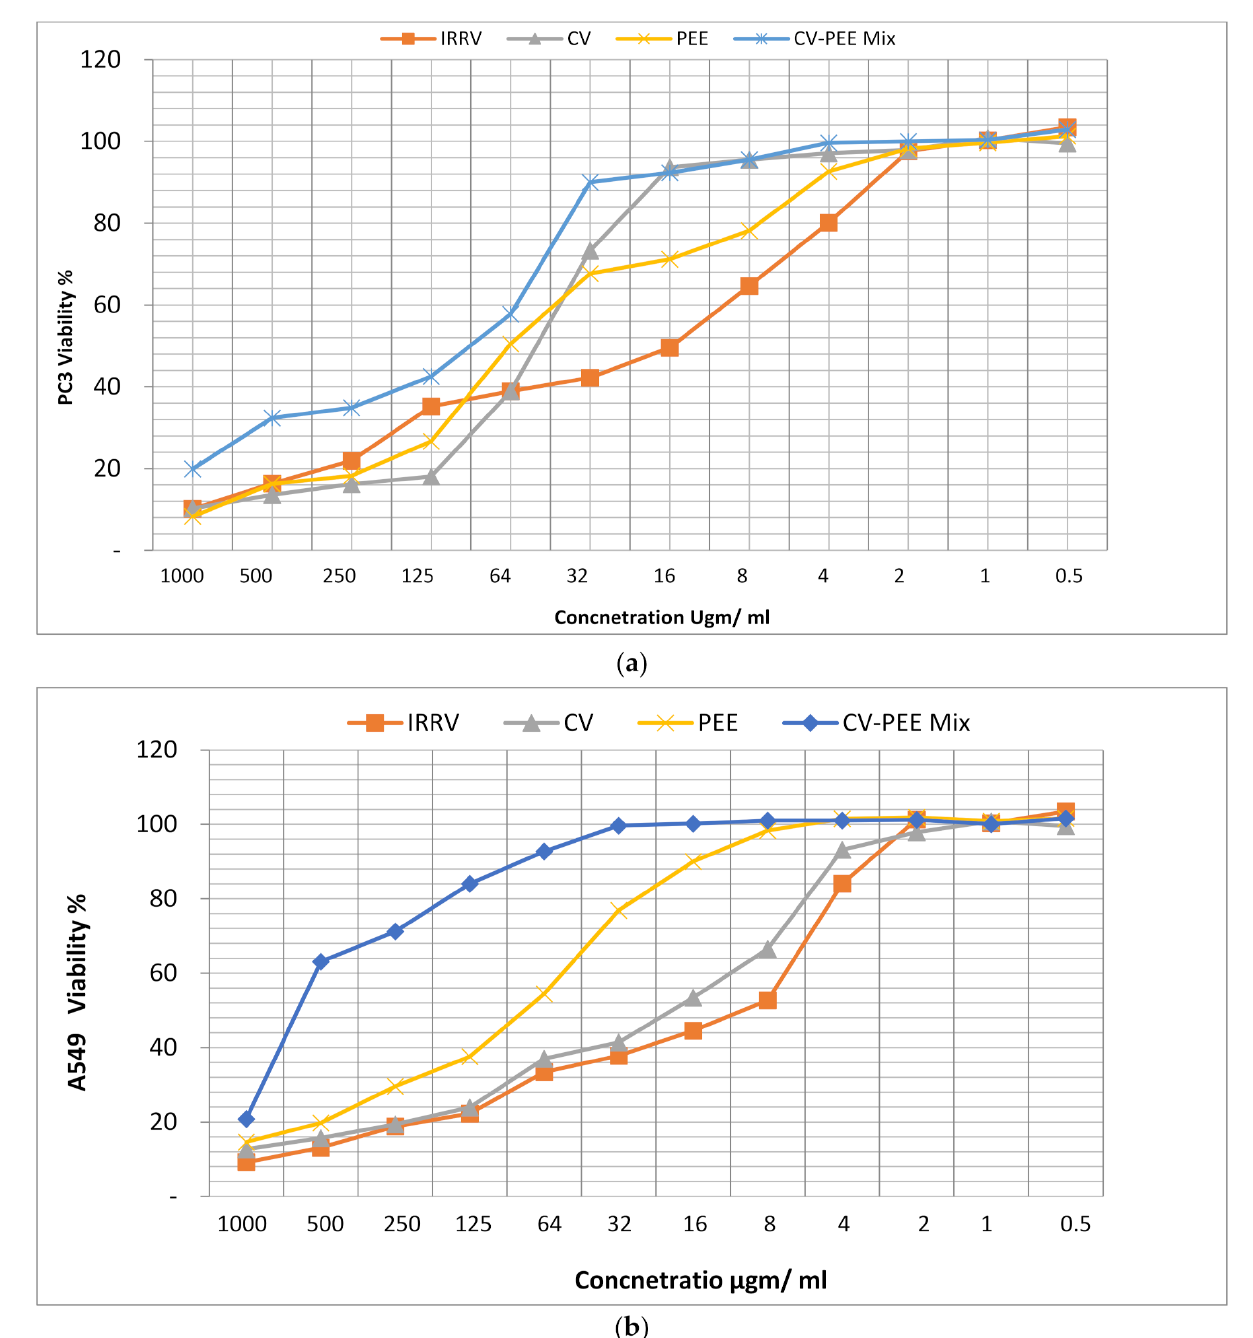
Figure 1. ( a ) Evaluation viability of IRRV, CV, PEE, and CV-PEE Mix against A549 cell lines post 24 h using MTT assay. ( b ) Evaluation viability of IRRV, CV, PEE, and CV-PEE Mix against PC3 cell lines post 24 h using MTT